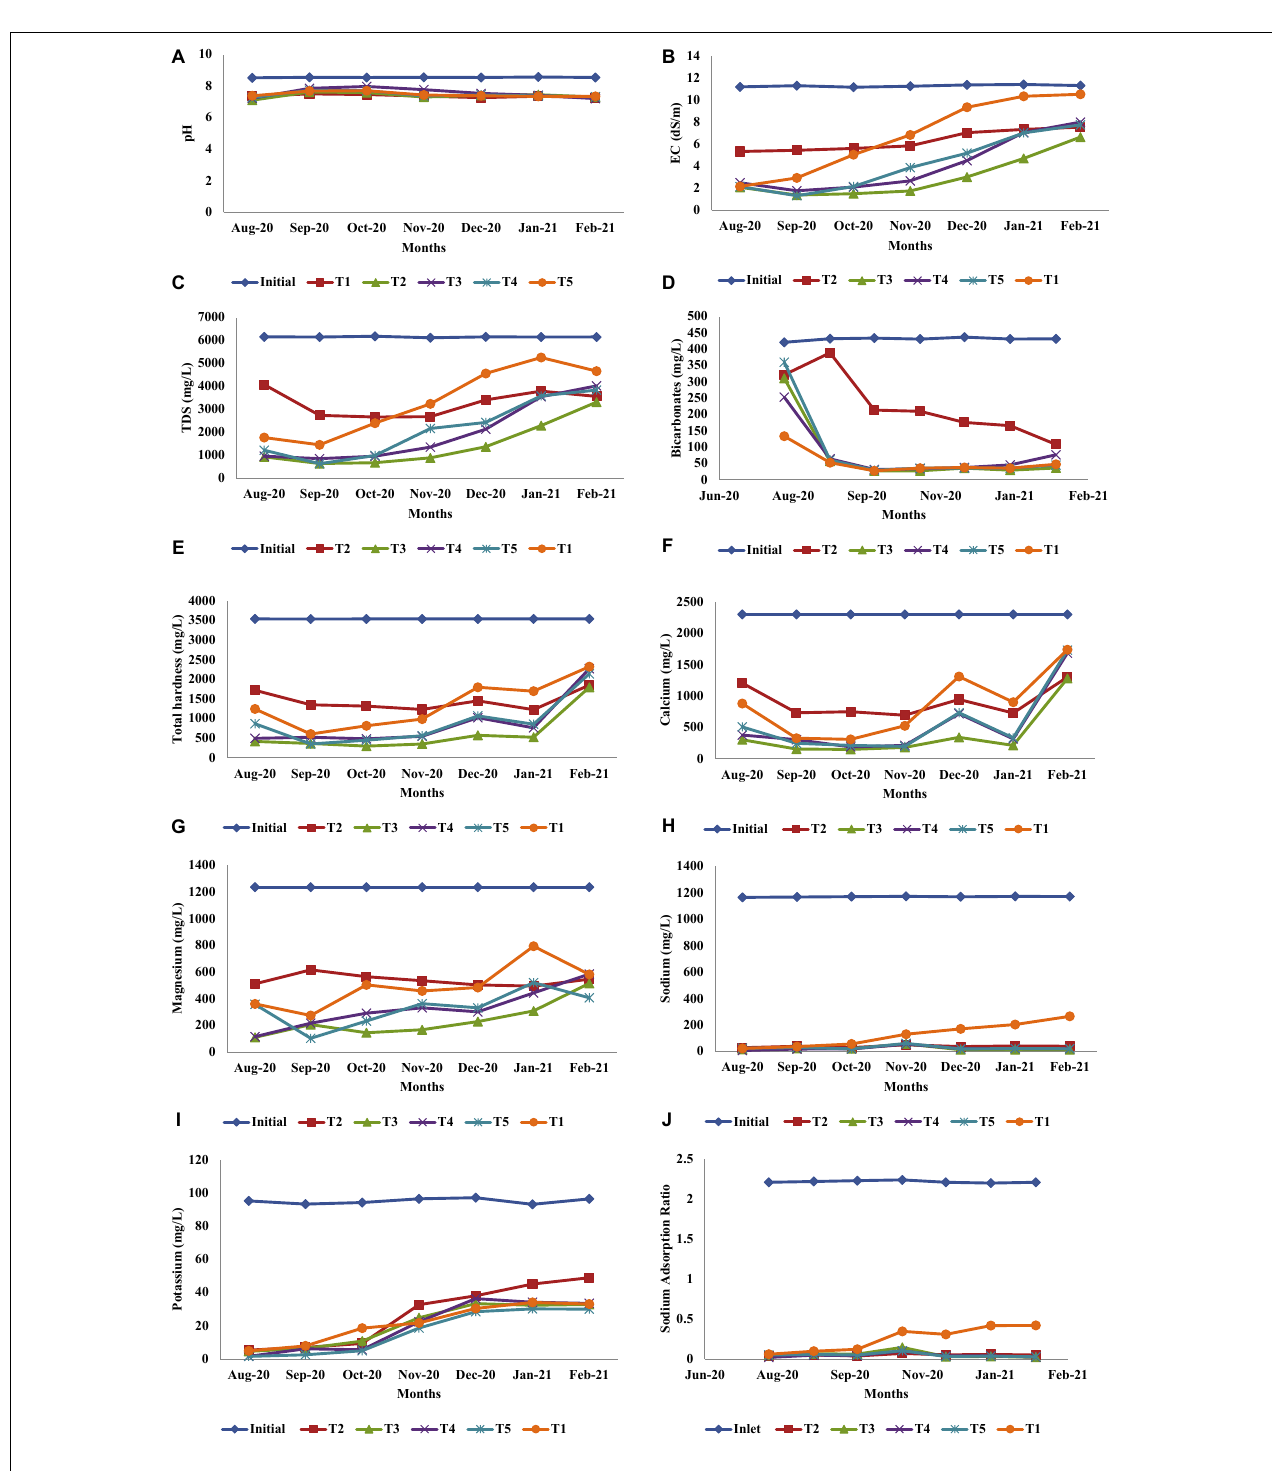
FIGURE 2 | (A–J) Variation in different physicochemical characteristics of leachate in different treatments throughout the study with respect to the pH (A) , EC (B) , TDS (C) , bicarbonates (D) , total hardness (E) , calcium (F) , magnesium (G) , sodium (H) , potassium (I) , and SAR (J) .